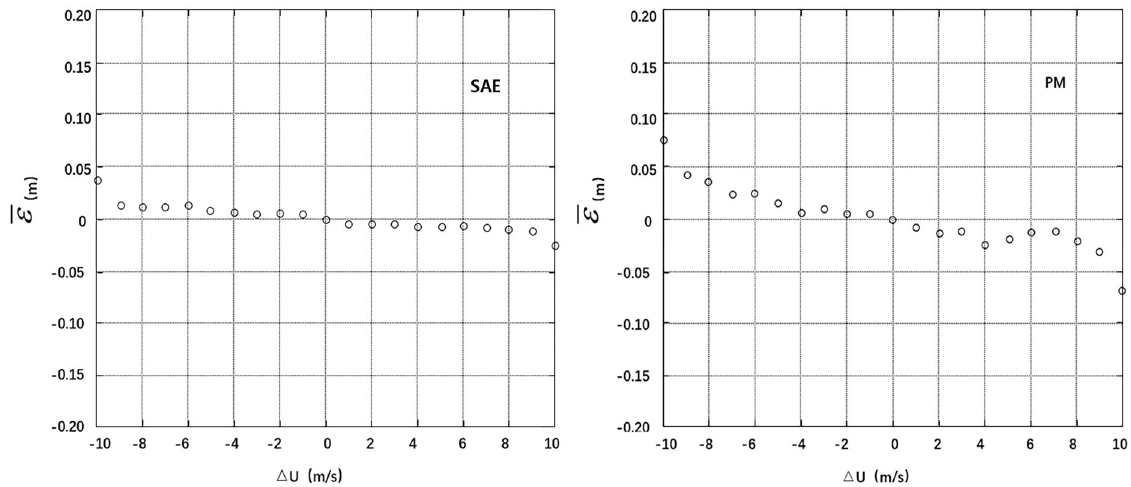
Fig 5. Distributions of mean residuals � ε according to Δ U.